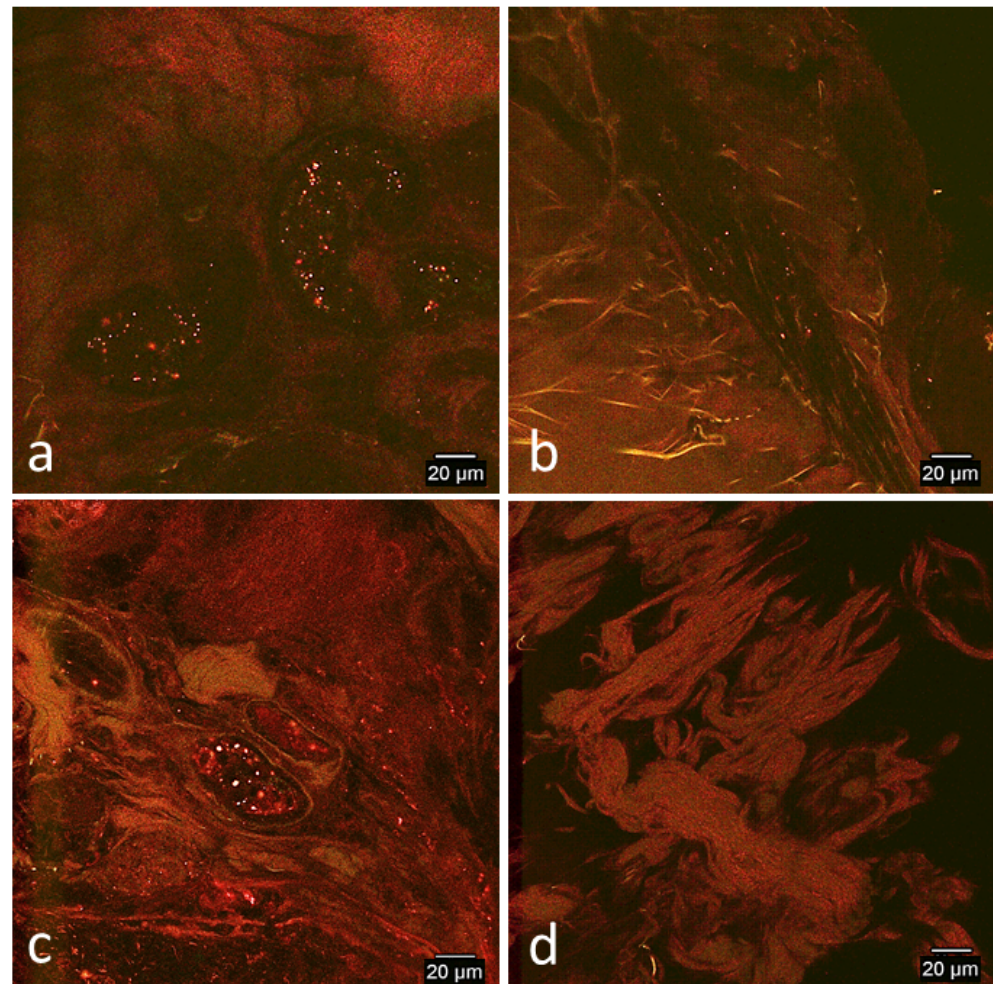
Figure 4. Representative confocal microscopy images of biopsies of limb and thoracic wounds and contralateral non-wounded skin on day 1. ( a ) Wounded limb, ( b ) non-wounded limb, ( c ) wounded thorax, and ( d ) non-wounded thorax. Images were selected from either horse based on best representation of patterns typical fluorescent signal patterns of both horses. Images have been selectively enhanced for purposes of demonstrating signal variation. There was slightly more homing to wounded limbs ( a ) and wounded thoraces ( c ) than the non-wounded sites ( b , d ). Red and green signal was highly concentrated in vasculature of wounded biopsies.